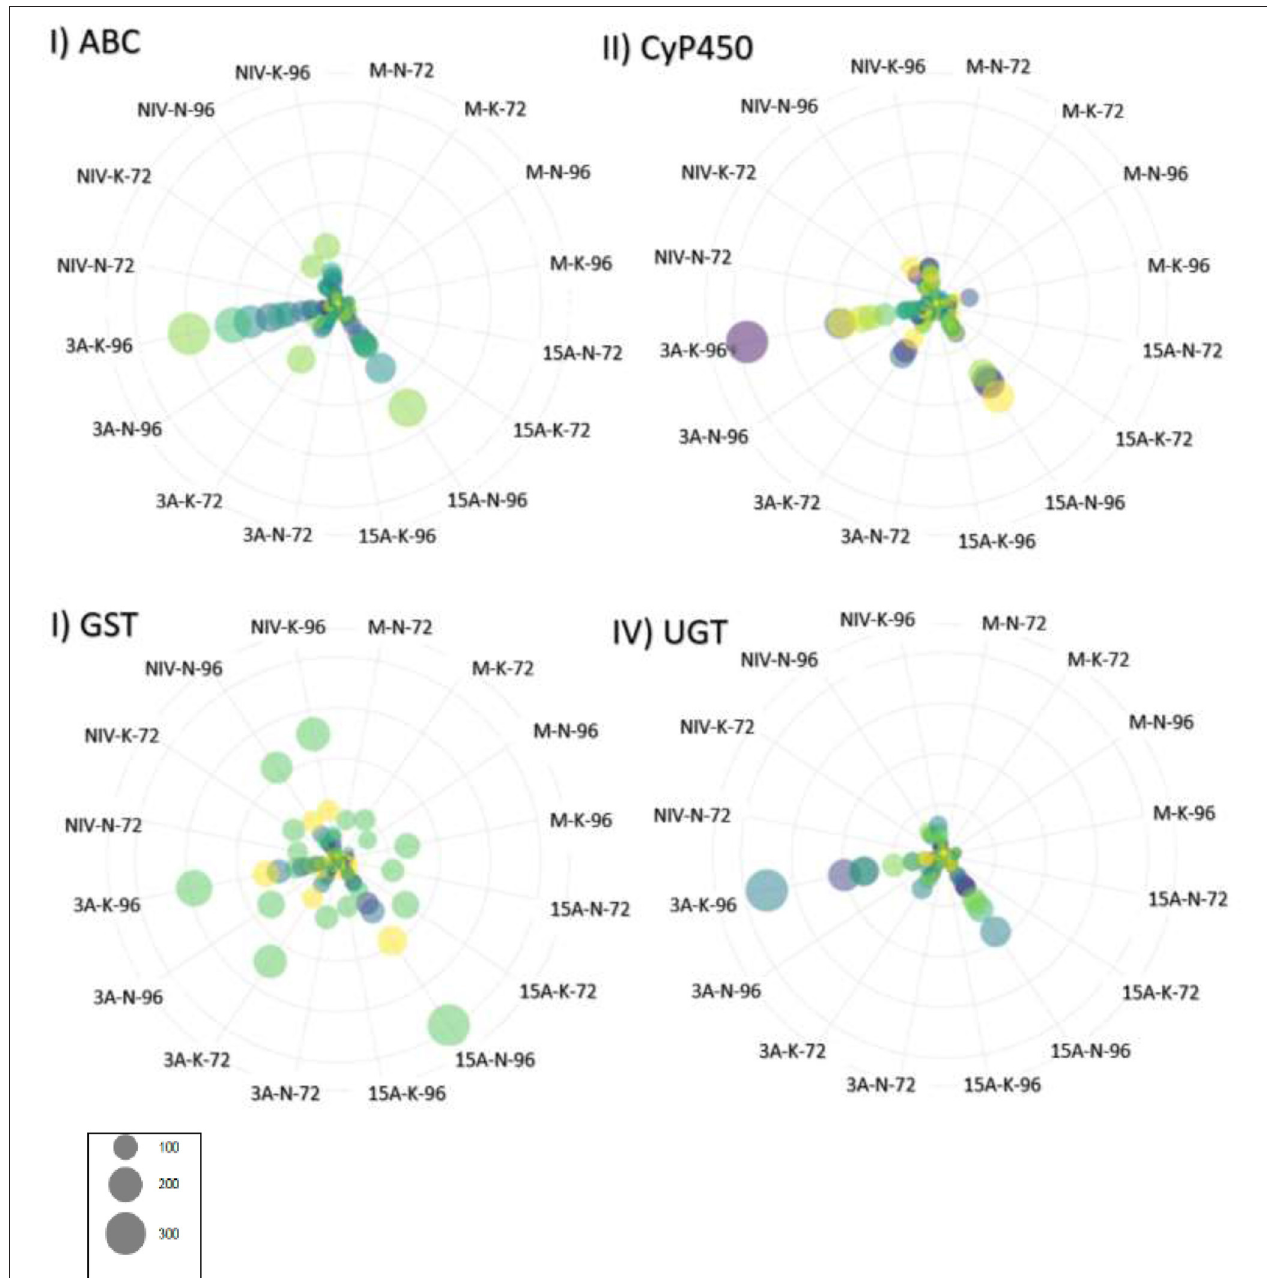
FIGURE 4 | Gene expression for gene families associated with resistance to deoxynivalenol (DON) expressed in transcripts per million (TPM). Genes are identified by color, and circle size corresponds to TPM. (I) ABC, ATP-binding cassette transporter ( n = 24 genes); (II) CyP450, cytochrome P450 superfamily protein ( n = 42 genes); (III) GST, glutathione S-transferase (16 genes); (IV) UGT, UDP-Glycosyltransferase superfamily proteins (36 genes). M, mock control; 3ADON, 3-acetyldeoxynivalenol; 15ADON, 15-acetyldeoxynivalenol; NIV, nivalenol. 72-and 96-h post-infection.